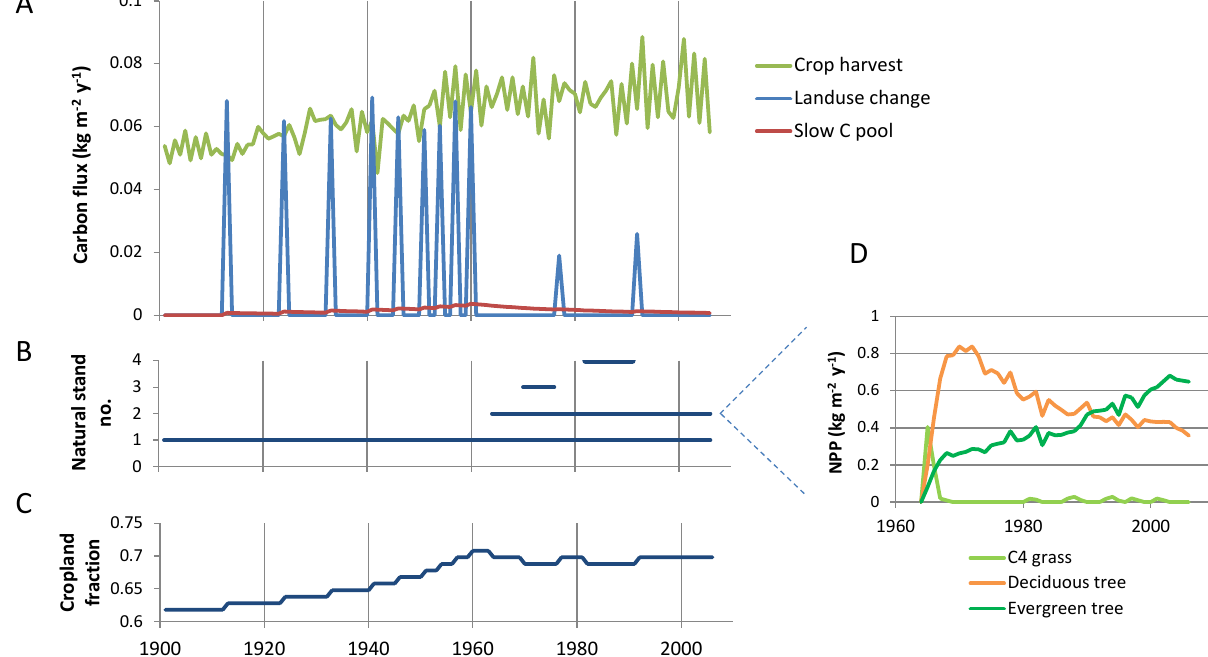
Fig. 3. Example of land use change modelling at a moist tropical site (9 ◦ W, 5.5 ◦ N) during the period 1901–2006 using the Ramankutty and Foley (1999) land cover data set. (A) Carbon fluxes to the atmosphere associated with crop harvest and land use change (cropland expan- sion/deforestation). The “slow C pool” represents the oxidation of carbon from the long-lived wood pool harvested at cropland expansion. (B) Lifetime of natural vegetation stands. New stands are created at cropland abandonment and destroyed at subsequent cropland expansion. (C) Cropland area fraction, showing the expansion and reduction of cropland area. (D) NPP of three PFTs at one of the natural stands cre- ated at cropland abandonment, representing a typical plant successional sequence where an initial dominance of grass is followed by forest, dominated first by deciduous and later by evergreen trees.